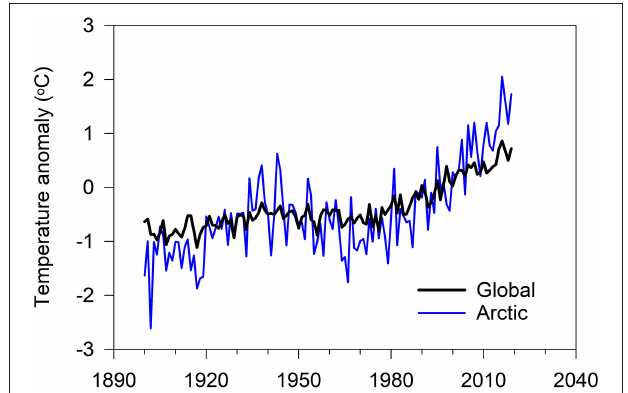
FIGURE 2 | ‘Arctic’ (land stations north of 60 ◦ North latitude) and global annual surface air temperature anomalies 1900–2019 ( ◦ C) relative to the 1981–2010 regional mean values. Updated from Overland et al.